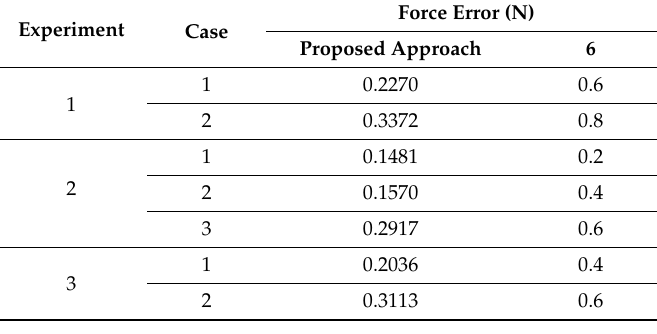
Table 6. The force errors of comparative experiments.